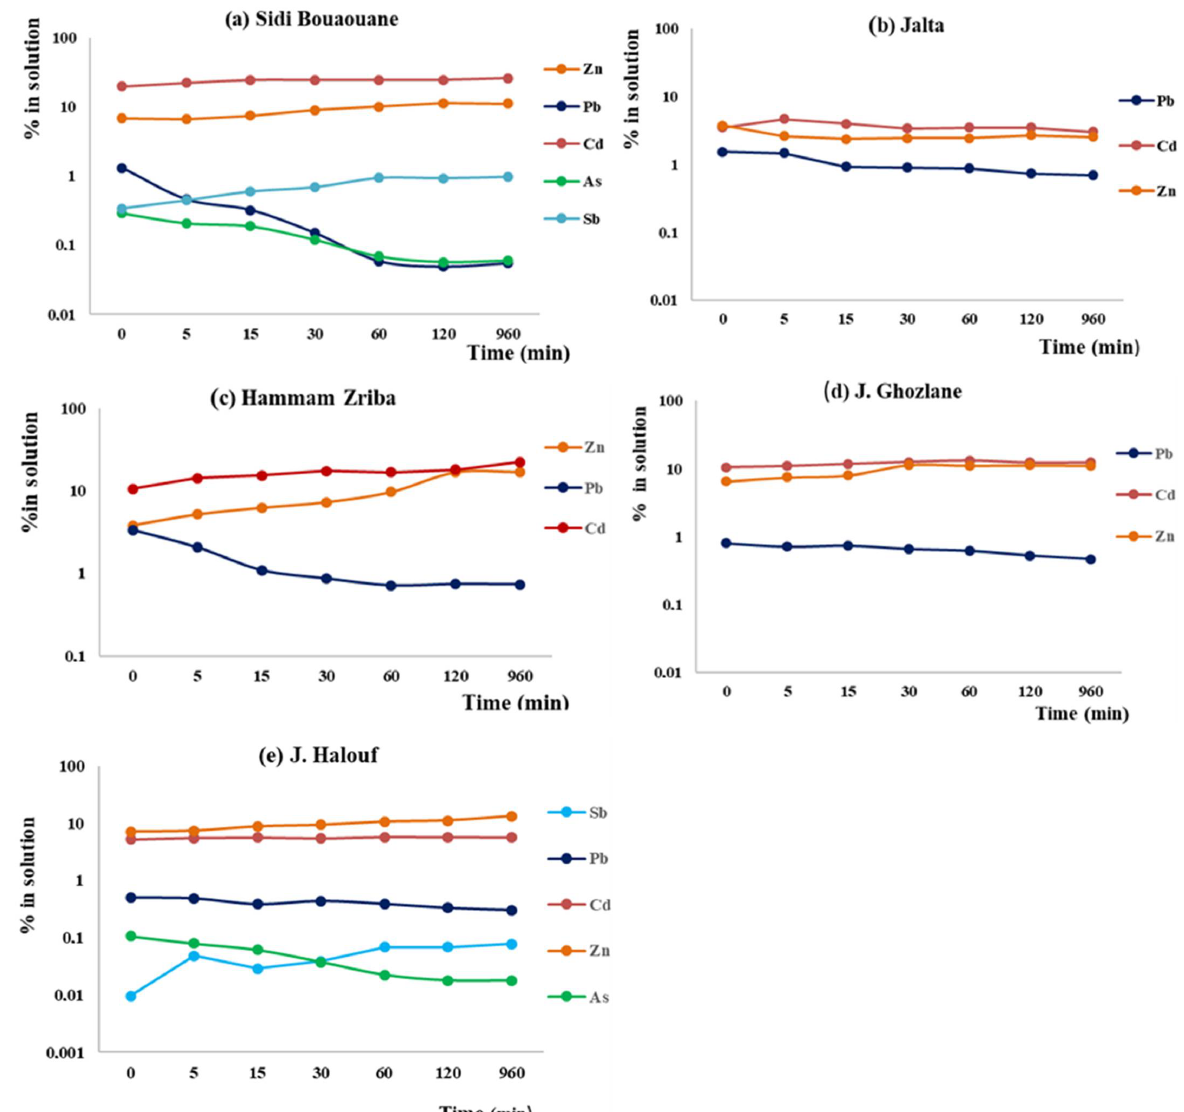
Figure 5. Evolution of the extraction rate (%) of Pb, Zn, Cd, As and Sb during the leaching test conducted on the studied soils ( a ): Sidi Bouaouane, ( b ): Jalta, ( c ): Hammam Zriba, ( d ): Ghozlane, and ( e ): J. hallouf.